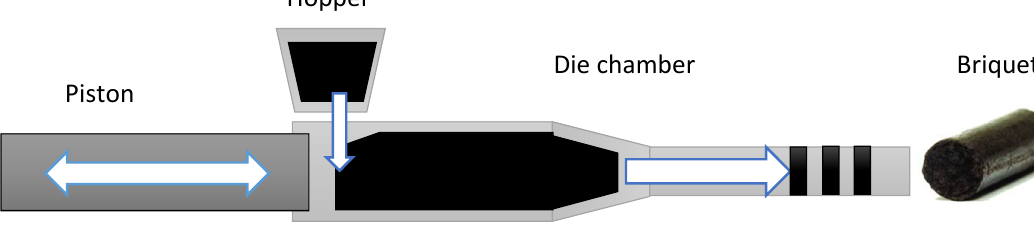
Figure 3. Schematic of briquette production process in a pilot scale briquette press. Table 2. Moisture content of the torrefied material used for briquetting tests.